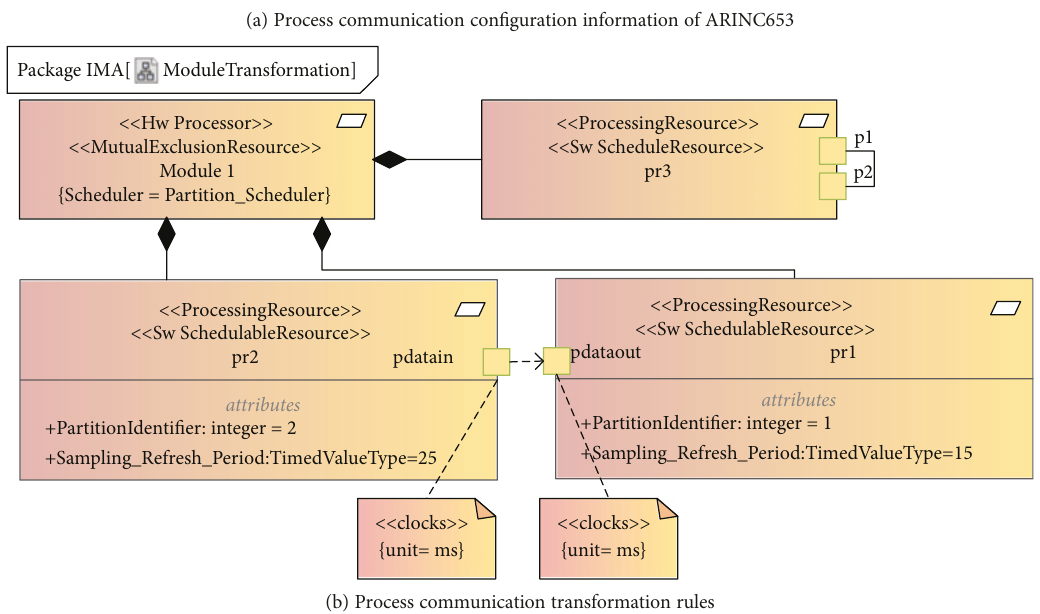
Figure 6: Process con fi guration transformation from ARINC653 to